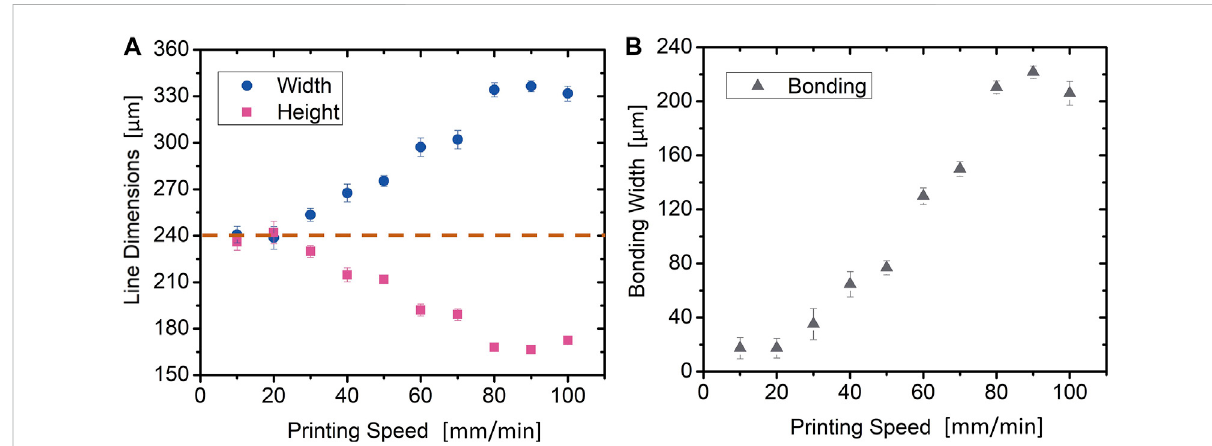
FIGURE 7 The measured line height and width (A) as a function of printing speed, derived from Figure 4, with (B) showing the corresponding bonding width. The dashed line in (A) indicate height and width (240 µm) for an ideal cylindrical line. Error bars are standard deviation ( n =